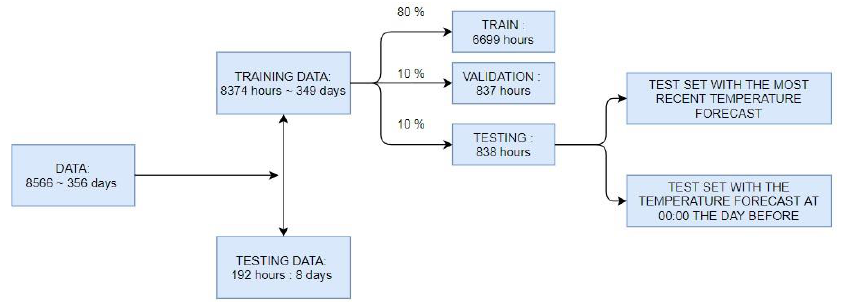
Figure 6. Division of the original dataset (365 days) into testing and training data. The testing data were used as a complementary means to further analyze the generalization performance of the resulting model. The remaining training data were divided as usual: 80% train, 10% validation, and 10% testing.